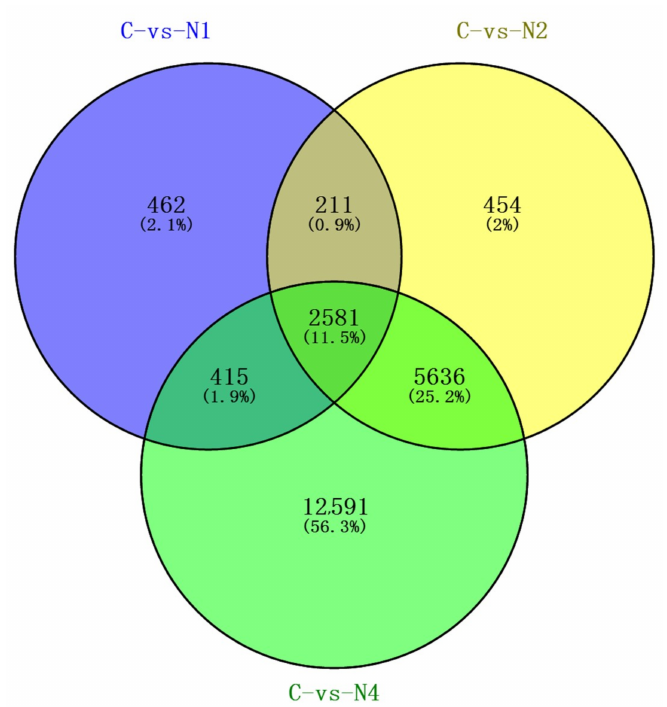
Figure 4. The Venn diagram of DEUs. Venn diagram representing the distribution of NaCl-responsive genes. The numbers in the Venn diagram indicated total numbers of regulated genes in the unique